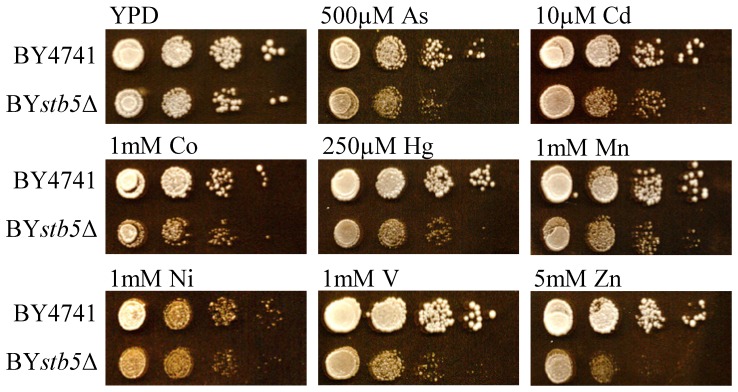
Growth assays with stb5Δ mutants.Serial 10-fold dilutions of BY4741 and BYstb5Δ cells were spotted onto metal-containing YPD plates (as indicated in the figure) and scored after 48 h.